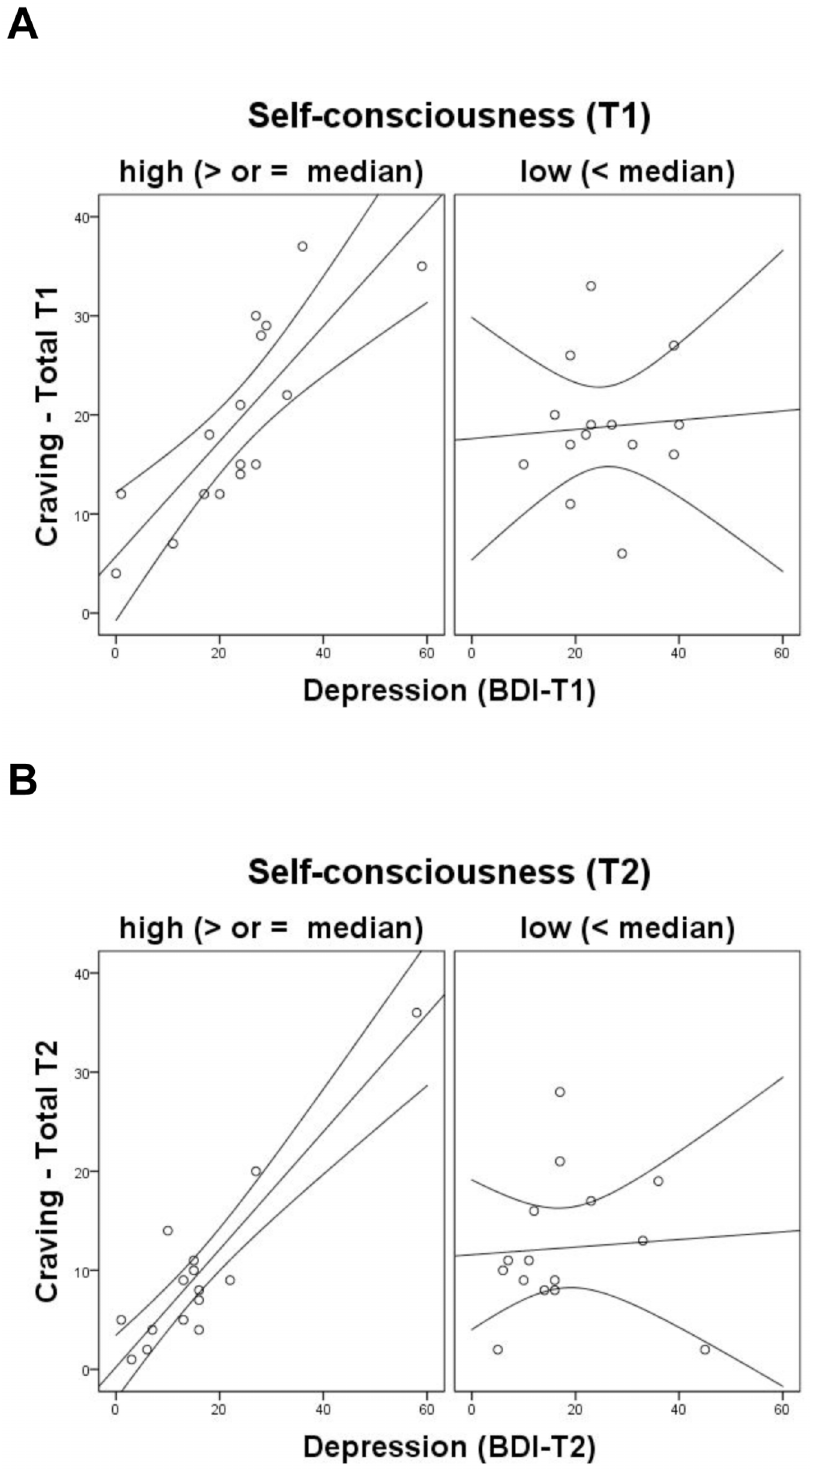
Figure 2. Relation between craving and depression scores as a function of self-consciousness. The relations were depicted for T1 (panel A) and T2 (panel B). In the four graphs, the curves around the regression line delineate a 95% confidence relation between craving and depression scores.